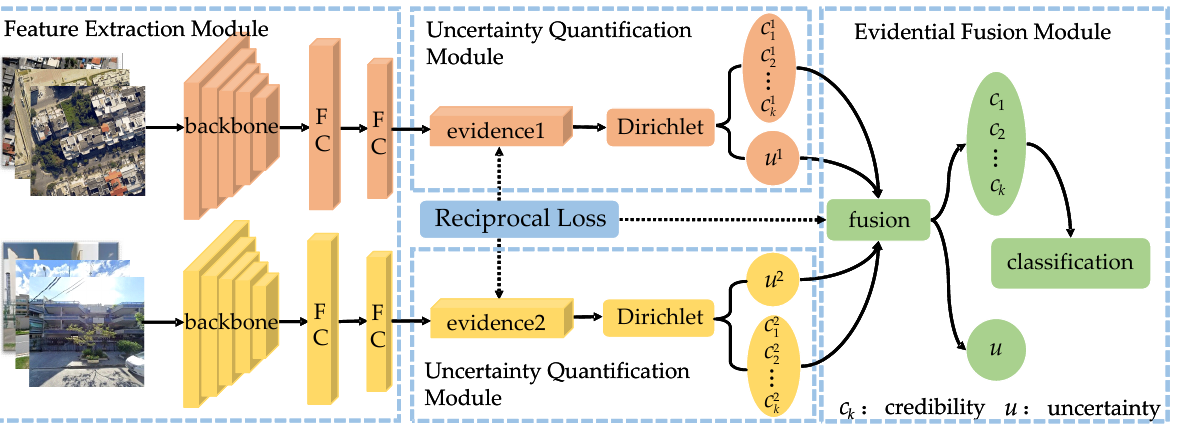
Figure 3. The overall framework of proposed Evidential Fusion Network (EFN) on aerial-ground dual-view